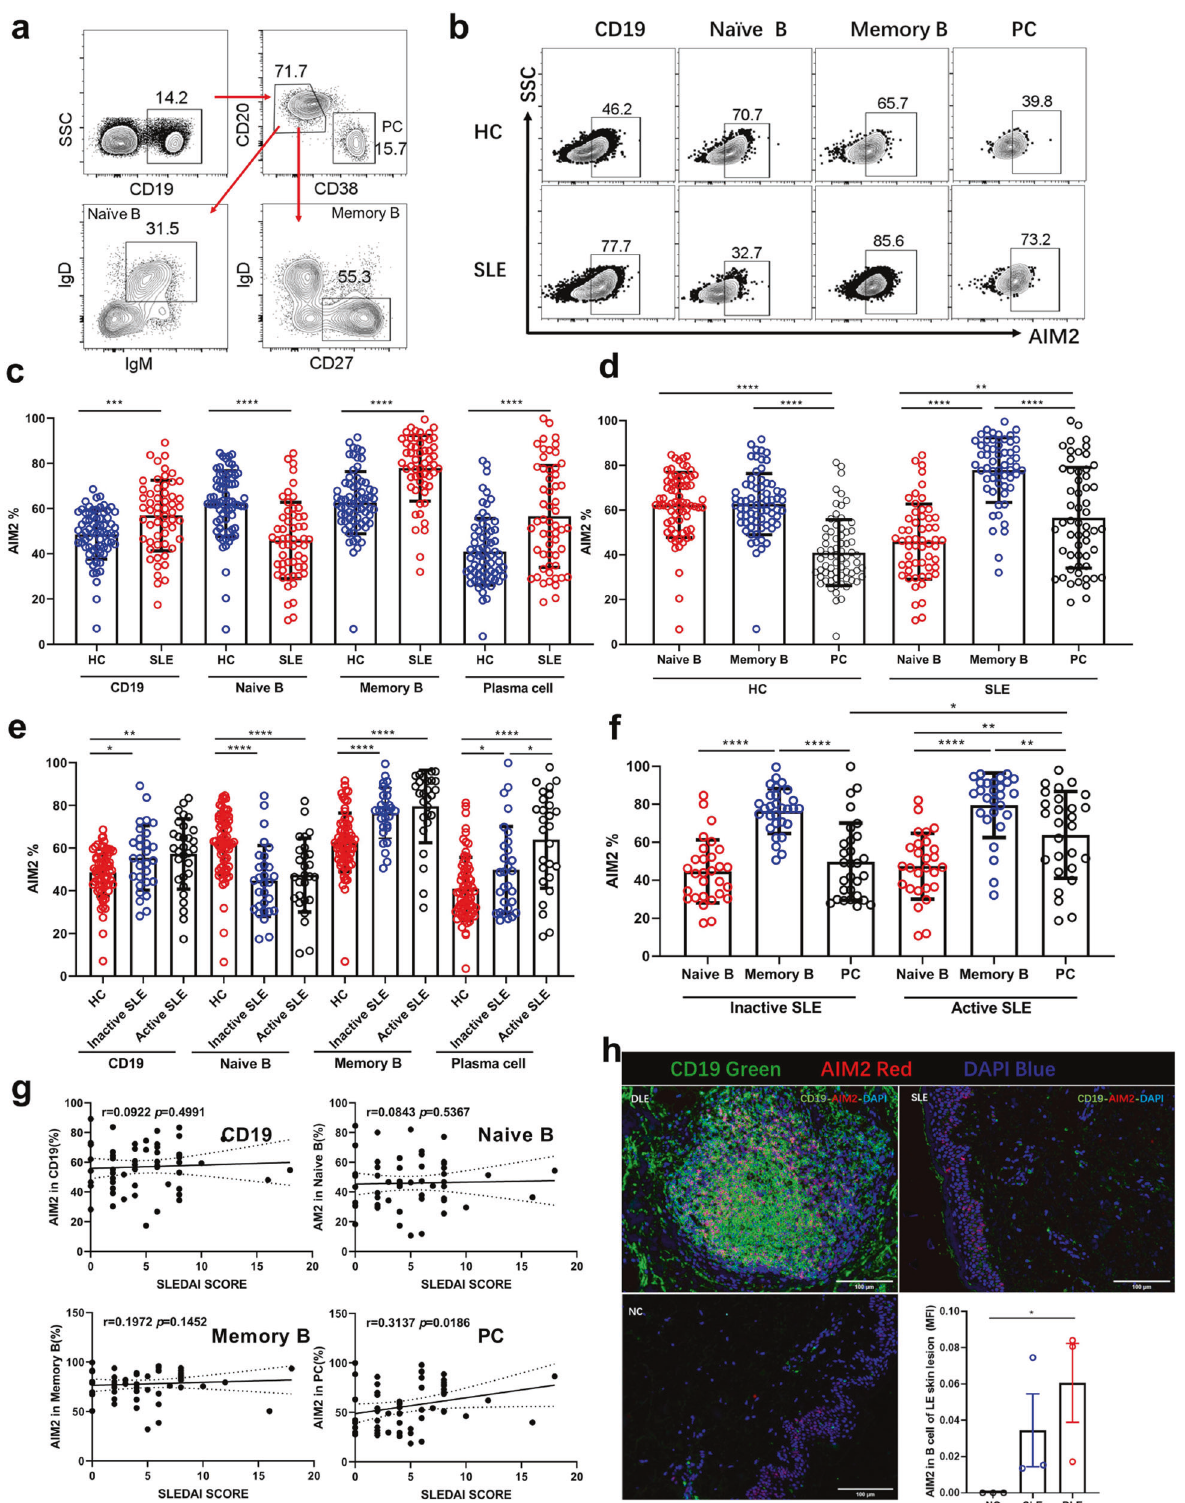
Fig. 1 The expression of AIM2 in circulating B cells and skin B cells from SLE patients. The expression of AIM2 was detected by fl ow cytometry and multicolor microscopy. a Representative fl ow diagram of gating for plasma cells, naive B cells, and memory B cells. b Representative fl ow diagram of AIM2 expression in plasma cells, naive B cells, and memory B cells from HC subjects ( n = 70), inactive SLE patients ( n = 29), and active SLE patients ( n = 27). c – g Statistical analysis of AIM2 + cells in populations of plasma cells, naive B cells, and memory B cells. h The location and expression levels of AIM2 in normal control (NC), SLE, and DLE skin samples. CD19 + B cells are in green, and AIM2 + cells are in red. Horizontal bars represent the mean ± SEM. * p < 0.05, ** p < 0.01, *** p < 0.005, **** p <